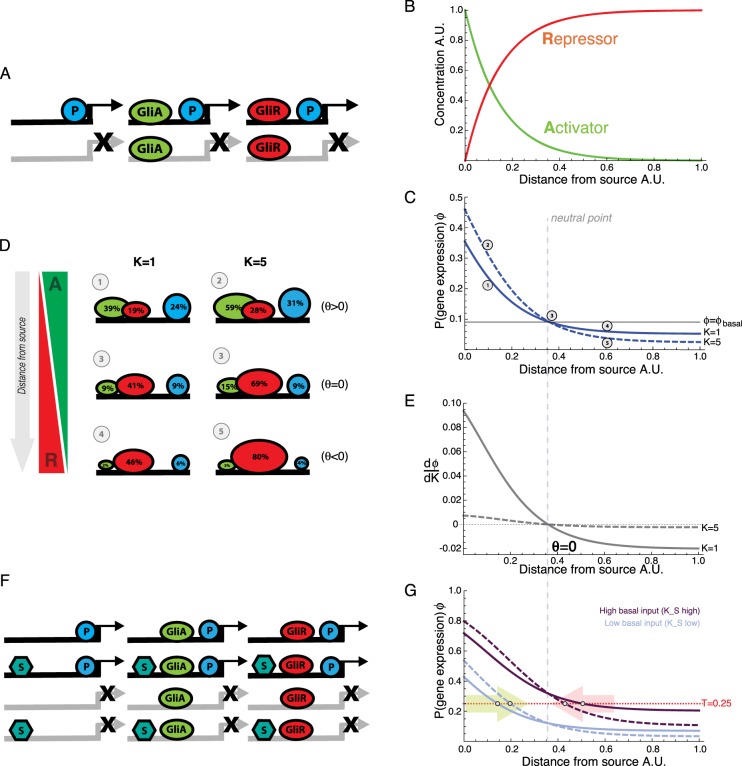
Model of a bifunctional morphogen effector explains how binding affinity affects gene responses. (A) All possible DNA binding configurations for the model described by Eq. 1. An enhancer composed of a single MR-TF (Gli) binding site regulates the recruitment of RNA polymerase (P) to the promoter. GliA or GliR binds at the enhancer in a mutually exclusive manner and increases or decreases (respectively) the probability of P binding at the promoter of the target gene. All transcriptionally active configurations (those with bound P) are shown with black arrows; inactive configurations are shown with crossed grey arrows. (B) For simulations, opposing gradients of activator [A] and repressor [R], which are representative of the bifunctional morphogen effectors (Gli/Ci) in a Hh morphogen gradient, were used. These were defined such that A=e−x/0.15, R=1−A. (C) Spatial gradients of the activator [A] and repressor [R] isoforms of Gli from (B) applied to a model of gene expression with a single Gli binding site (GBS) (Eq. 1). The probability of gene expression, ϕ, decreases as a function of distance from the source for target genes containing a low-affinity site (solid blue line, K=1) or a high-affinity site (dashed blue, line K=5). Close to the source there is an increase in gene expression when the binding affinity, K, for Gli is increased (compare positions 1 and 2). Far from the source there is a decrease in gene expression when binding affinity is increased (compare positions 4 and 5). The solid grey line indicates the basal level of gene expression and the dashed line the neutral point in the gradient (position 3). Remaining parameters: [P]=0.1, KP=0.5, cAP=10, cRP=0.1. (D) The percentage occupancy for GliA (green oval) and GliR (red oval) at the GBS (derived from Eq. 3 and Eq. 4) and P (blue circle) at the promoter (derived from Eq. 1) for different positions in the gradient depicted in the simulations in C (grey circles 1-5 located at x=0.1, x=0.35, x=0.6 A.U.) with different values of Gli binding affinity (K=1 and K=5) as indicated. (E) The rate of change of gene expression probability with respect to Gli binding affinity dφ/dK (Eq. 5) shown for the two cases illustrated in C. The neutral point occurs at θ=0, where the rate of change is equal to zero. θ (Eq. 6) is determined only by the concentrations of GliA and GliR and the strength of their effect on P binding (cAP and cRP). (F) All DNA binding configurations for the model described by Eq. 7. A ubiquitously expressed TF, S, binds to the enhancer and increases the probability of P recruitment, independently of GliA and GliR binding. (G) Gene expression for two MR-TF-controlled genes, A and B (blue and purple curves), that have different basal levels of expression (Eq. 7). The blue curves (KS=0.1) have relatively low basal expression; the purple curves (KS=10) have a higher basal level of expression. Remaining parameters: [P]=0.1, KP=1, cAP=10, cRP=0.1. A threshold probability for gene activation is defined as T=0.25 (red line). An increase in GBS affinity (from K=1 solid lines, to K=5 dashed lines) increases the range of expression (above the threshold) of gene A (as indicated by the green arrow). Conversely, the range of expression of gene B is contracted towards the source (red arrow) when affinity is increased. For both genes, the neutral point (grey dashed line), at which the probability of gene expression does not change when K is altered, occurs at the basal level and is determined by the position in the gradient where θ=0 (as shown in E).